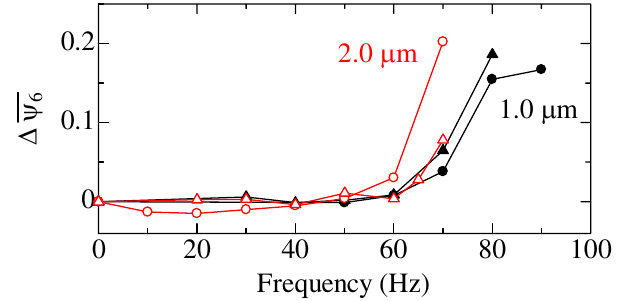
Figure 5. Changes in ψ for colloidal glasses composed of 1 μ m (filled symbols) and 2 μ m (open symbols) 6 particles, when horizontal oscillation was applied to them for 60 s at each frequency.